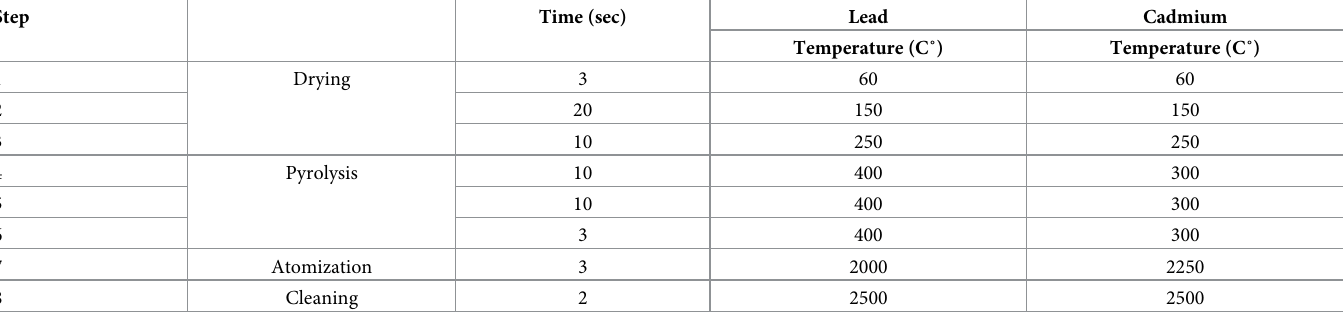
Table 2. Optimal graphite furnace temperature program for the detection of lead and cadmium in E . coli used for microwave assisted acid digestion (optimal method).